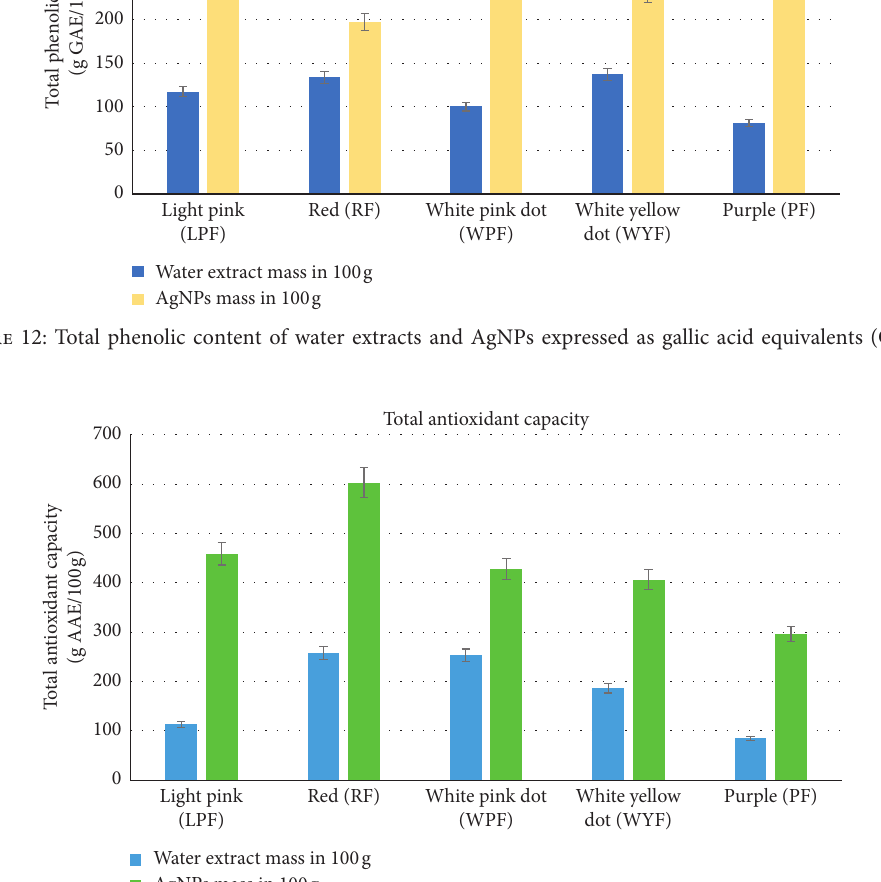
0.20.30.40.50.60.7